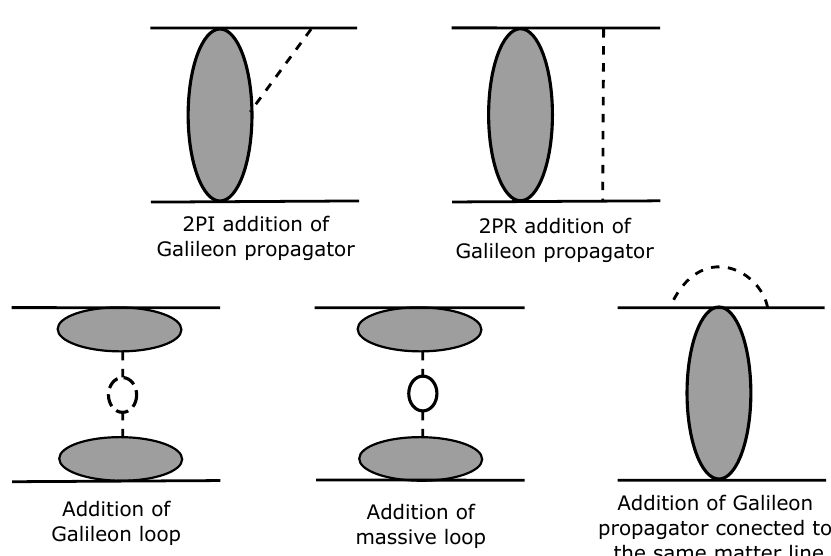
Figure 4 . Different possibilities of loop contributions by adding a new propagator or loop to a graph with classical contributions. The grey blobs represent classical contributions. When we have two blobs, these were classical without the new insertion between them. The graphs in the top row can contribute in the classical limit. The ones in the bottom row are always quantum in nature. the matter couplings scale in a different way than the self-interactions, insertions of loops scale differently than insertions of propagators connected to external massive scalars.